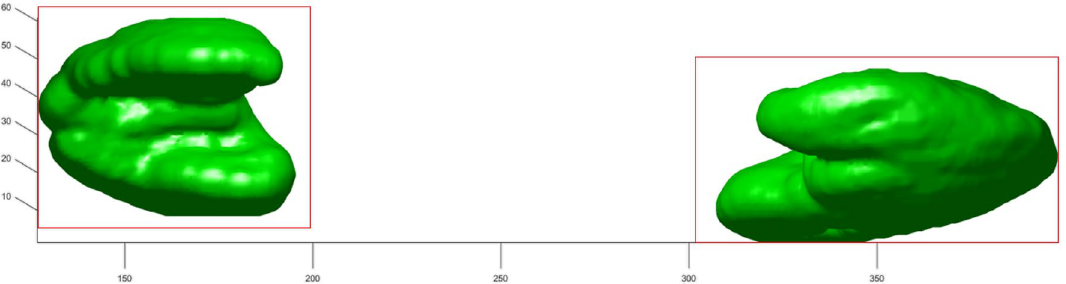
Figure 18. Precisely calculation of the ROI area allows for accurate segmentation of the organ.